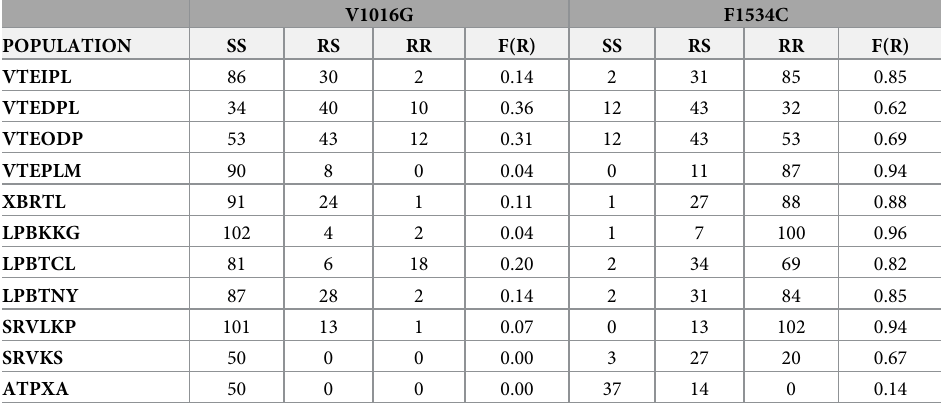
Table 4. Genotype distribution and allelic frequency of the V1016G and F1534C kdr